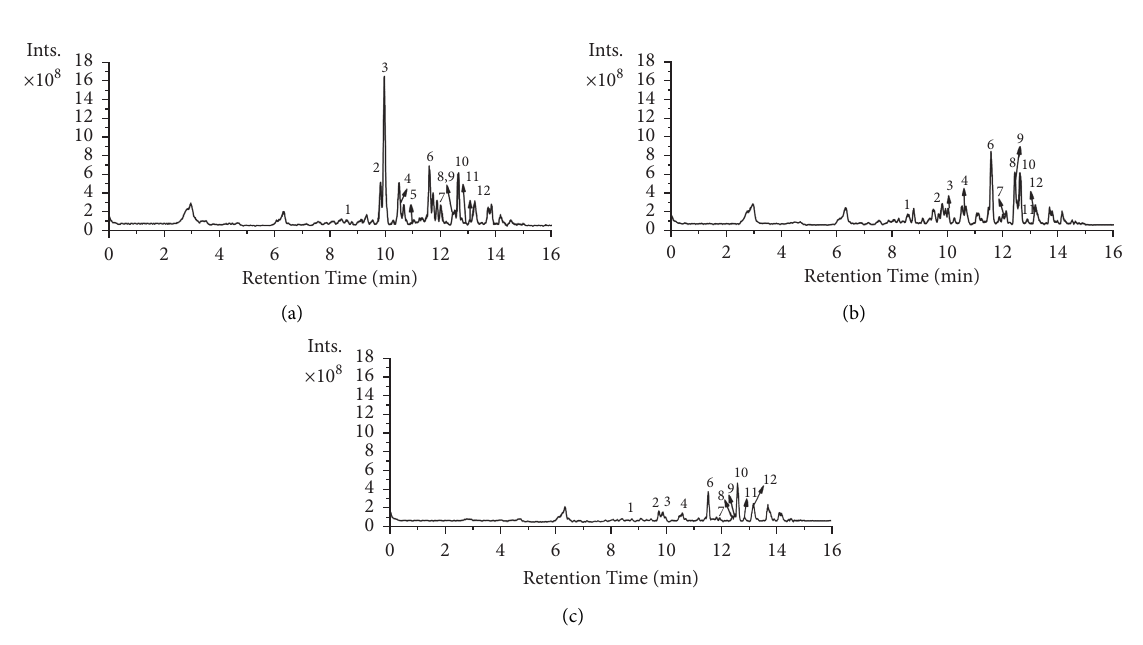
Figure 1: Total ion chromatograms (TICs) for the ethanol extracts of the (a) flowers, (b) leaves, and (c) stems of Prinsepia utilis Royle in negative mode. 1–12 refers to the corresponding compounds in Tables 1 and 2. Table 2: Identification of major polyphenols in the flower, leaf, and stem of Prinsepia utilis Royle using the negative ion mode of UPLC-ESI-